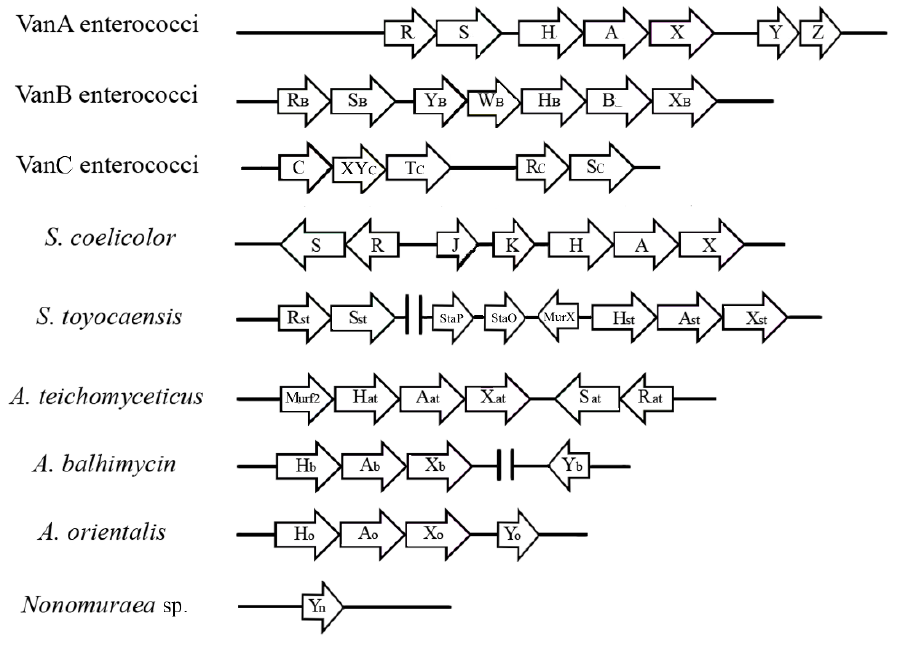
Figure 2. Comparison of resistance gene organization in enterococci (VanA, VanB and VanC phenotypes) in Streptomyces coelicolor and in GPAs-producers. Two parallel vertical lines indicate that genes that are not present in contiguous regions (figure modified from Yim et al.